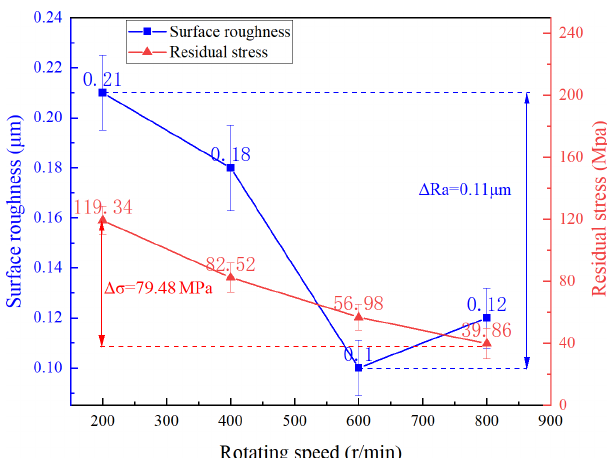
Figure 13. Effect of different spindle rotation on surface roughness of the